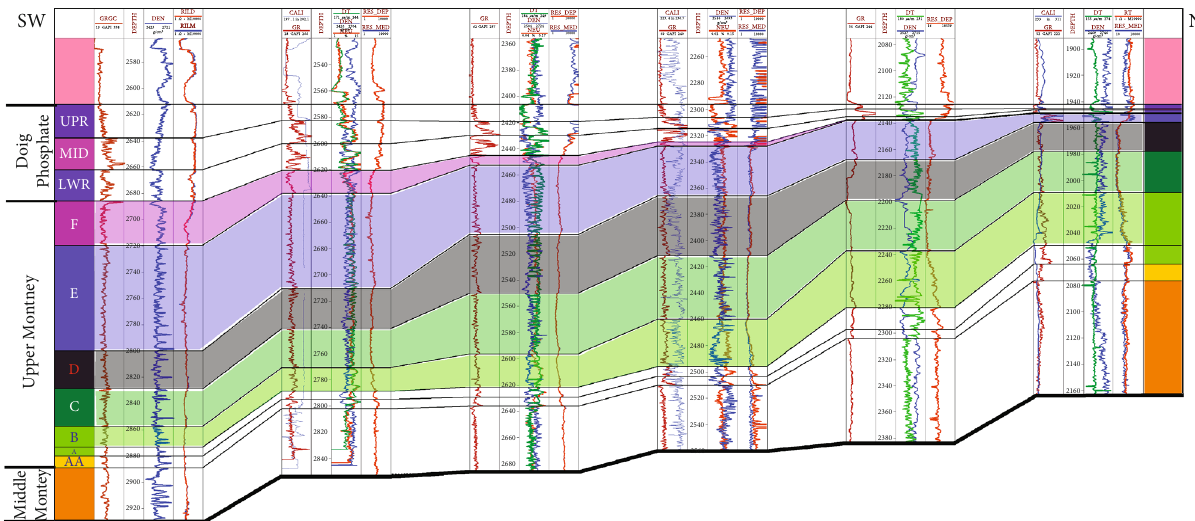
Figure 2: SW-NE cross-section of the Upper Montney Formation in the Groundbirch region.